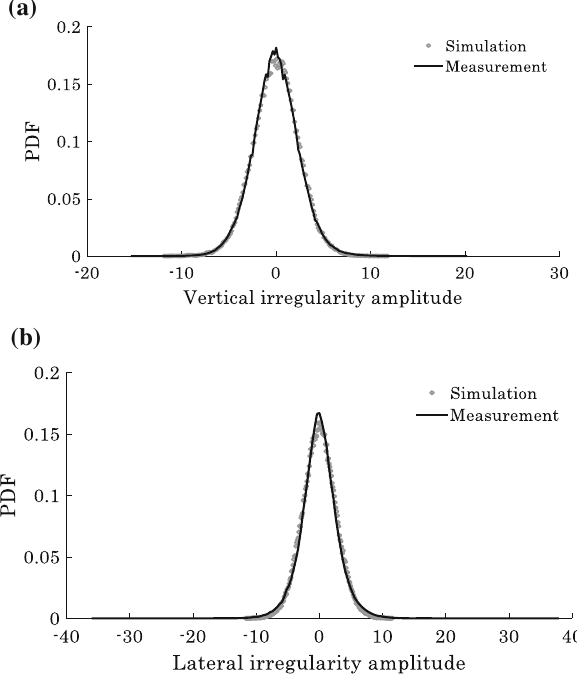
Fig. 5 PDF comparison between simulation and measurement ( a vertical irregularity m r ; b lateral irregularity c r